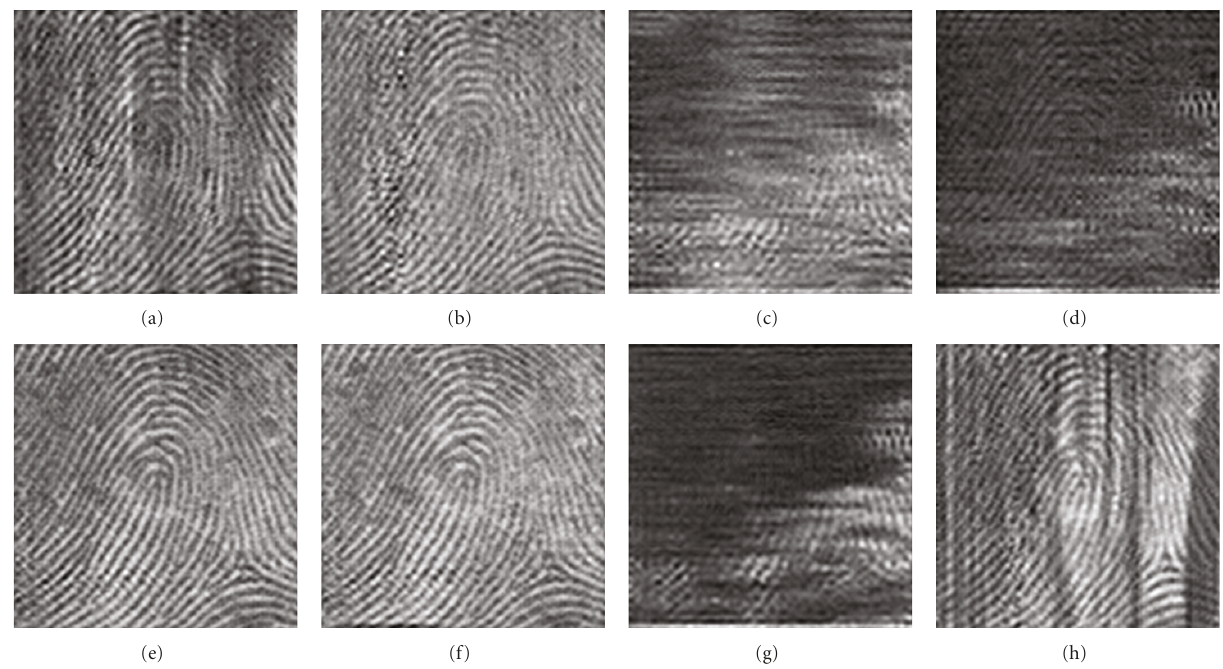
Figure 12: Recovered watermarks from Lena image under various filtering and enhancement attacks (a) FMLR, (b) Gaussian LPF, (c) hard thresholding (d) soft thresholding (e) reduce color (f) image sharpening (g) Wiener filtering (h) histogram equalization.